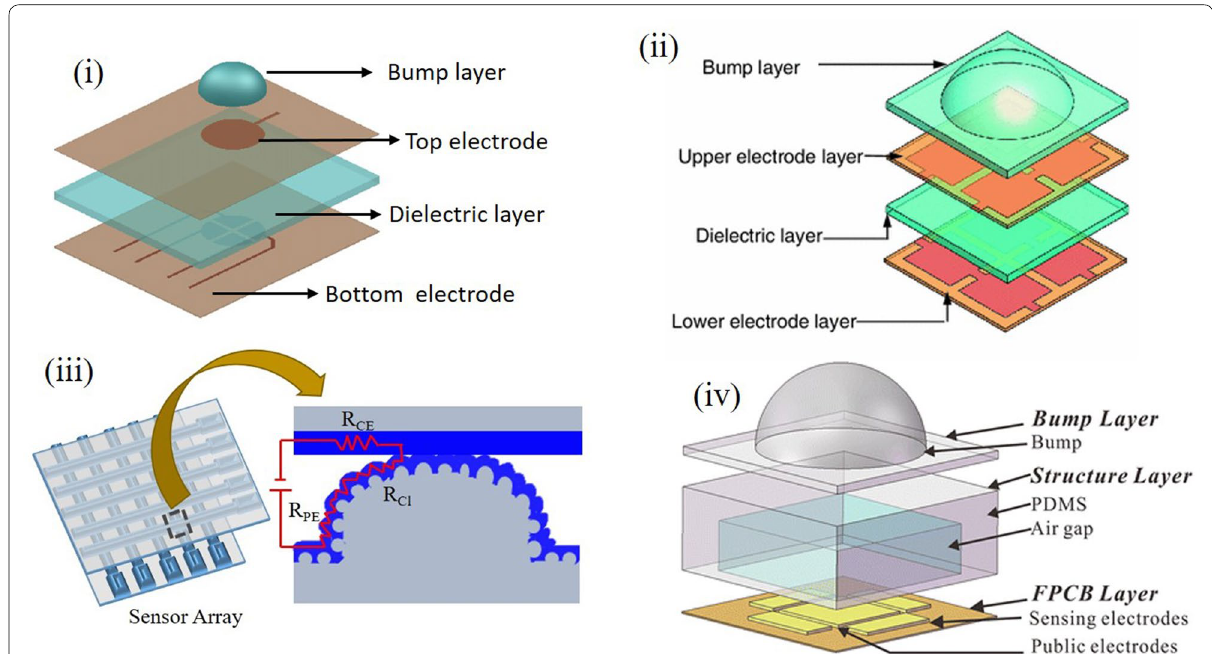
Fig. 3 Bumpy design PDMS sensor with (i) Plain top electrode (Reproduced with permission from [33] Copyright 2012, Elsevier ) (ii) Divided top electrode configuration (Reproduced by permission from [34] Copyright 2013, Springer ) (iii) Poly(3,4-ethylenedioxythiophene) poly styrene sulphonate (PEDOT:PSS) enhanced conductivity. (iv) Air gap model with PDMS bump (Reproduced by permission from [183] Copyright 2016, Springer